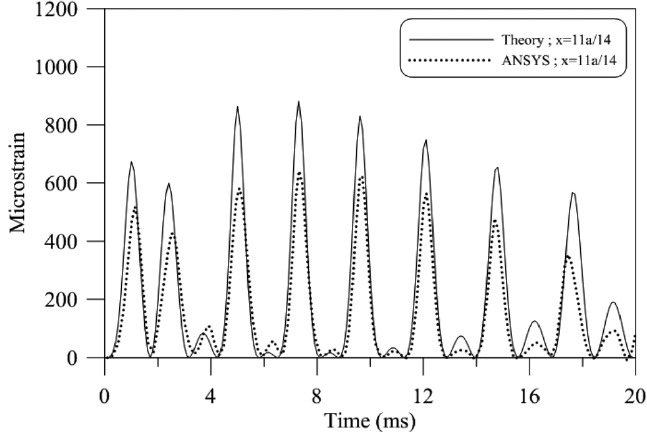
Fig. 10. The strain-time history ( ε xm − t ) at middle surface of point (11a/14, b/2).